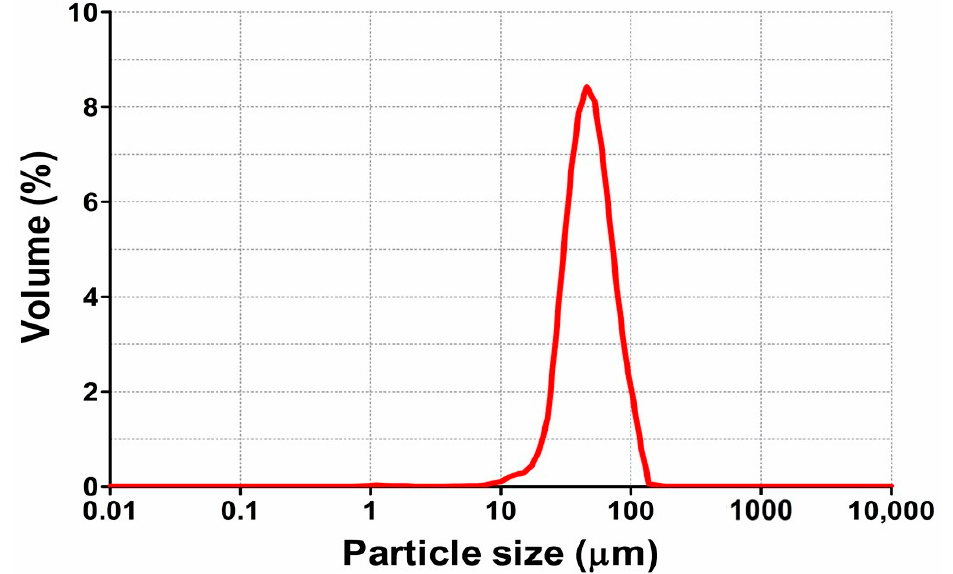
Figure 6. Particle size distribution of oregano microcapsules. Microcapsule formulation: wall material (10 g of gelatin, 7.5 g of gum Arabic, 1.99 g of Tween 20, 1.98 g of β -cyclodextrin) and 20 g of ethanolic oregano extract as the core. Spray-drying parameters: Inlet temperature—170 ° C, feed flow rate—40 mL/min, concentration of wall material in solution—20%.